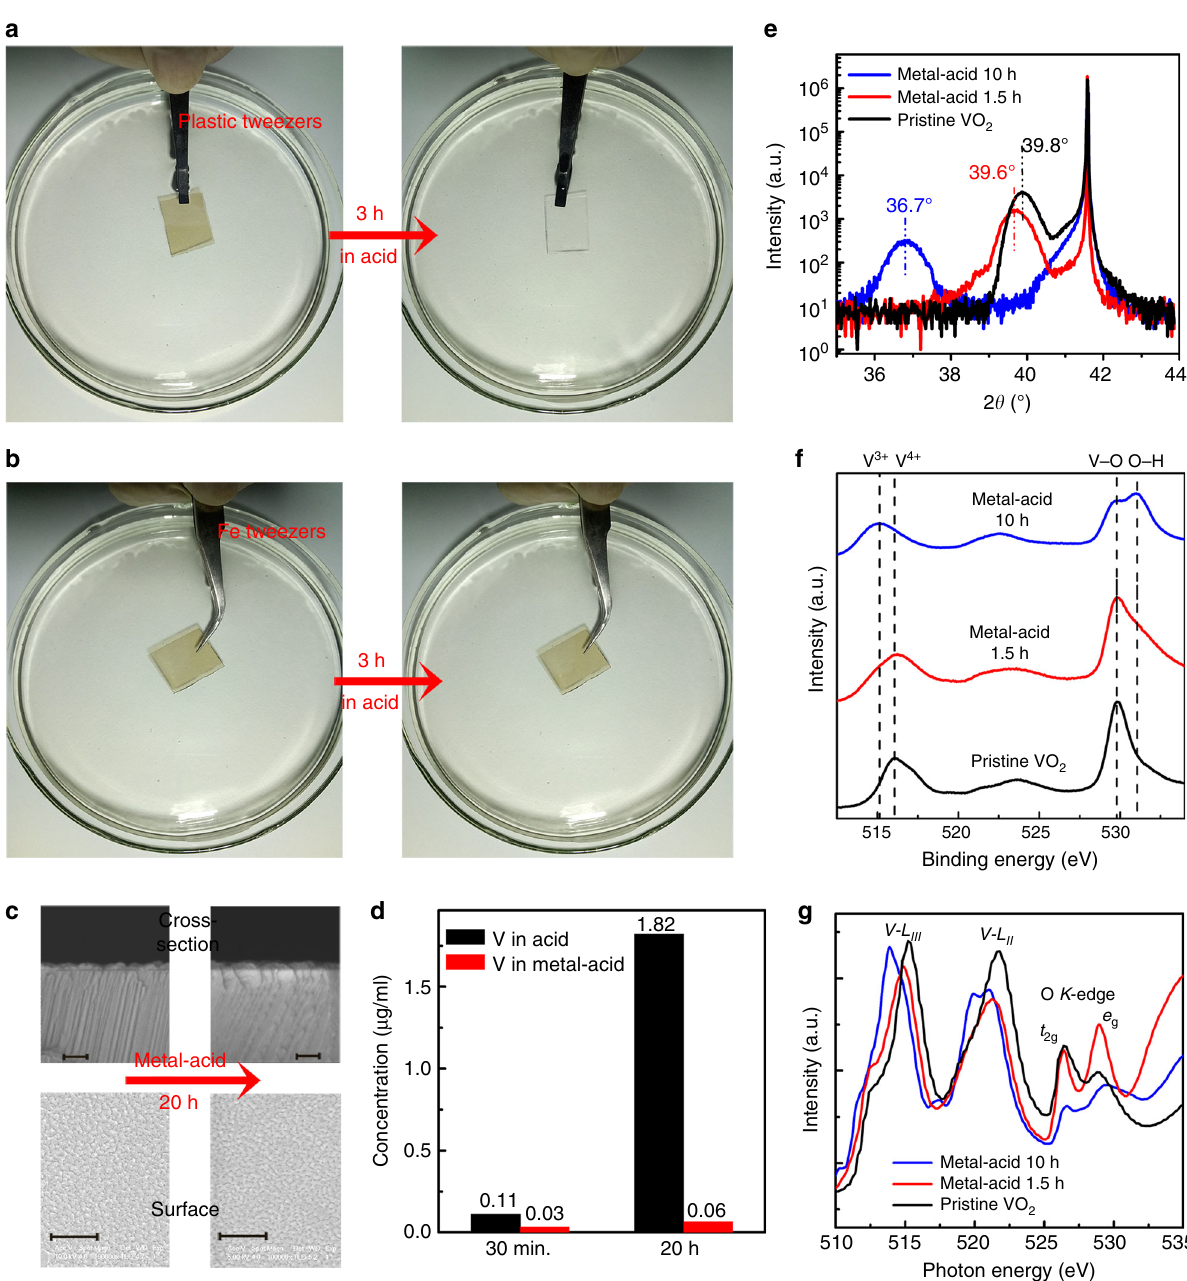
Fig. 1 Metal-acid treatment induced hydrogenation of VO 2 fi lm. a The VO 2 fi lm on Al 2 O 3 substrate held by a plastic tweezers was dissolved by 2%wt H 2 SO 4 acid in 3 h. b Although a steel (Fe) tweezers attachment made the fi lm intact in acid, showing pronounced anti-corrosion ability. c The SEM images for the cross-sections and surface morphologies of the VO 2 fi lm being treated by metal (Fe)-acid for 20 h, showing that the VO 2 fi lm maintains unchanged thickness and surface morphologies. The scale bar is 100 nm for the cross-sections and 500 nm for the surface morphologies, respectively. d Trace element analysis shows the V 4 + concentrations in solution changing from 0.11 to 1.82 μ g/ml after 30 min to 20 h with acid treatment, whereas very low V 4 + concentration at 0.03 – 0.06 μ g/ml is found at the same time period with metal (Fe)-acid treatment. The e XRD, f XPS, and g XANES characterizations for the pristine VO 2 and metal (Fe)-acid-treated samples for 1.5 and 10 h, respectively. The pronounced (020) XRD peak shift from 39.8° to 36.7°,